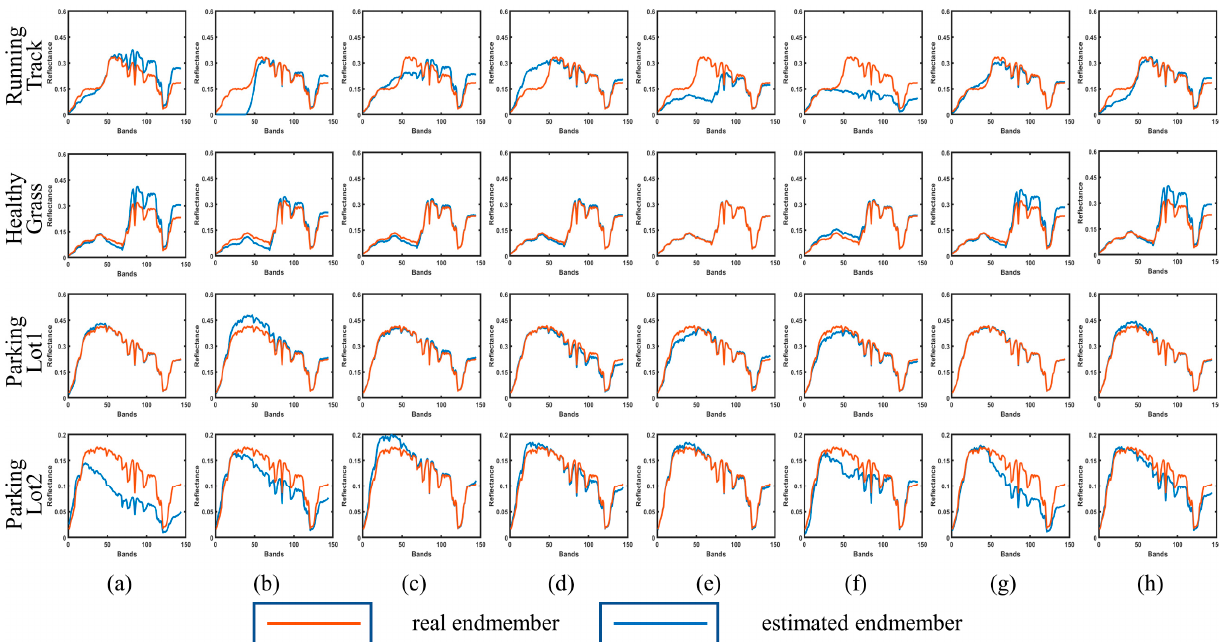
Figure 16. Visualization results of the endmembers of Houston data. ( a ) VCA-FCLS. ( b ) SGCNMF. ( c ) DAEU. ( d ) MTAEU. ( e ) CNNAEU. ( f ) CyCU-Net. ( g ) MiSiCNet. ( h ) SSANet.